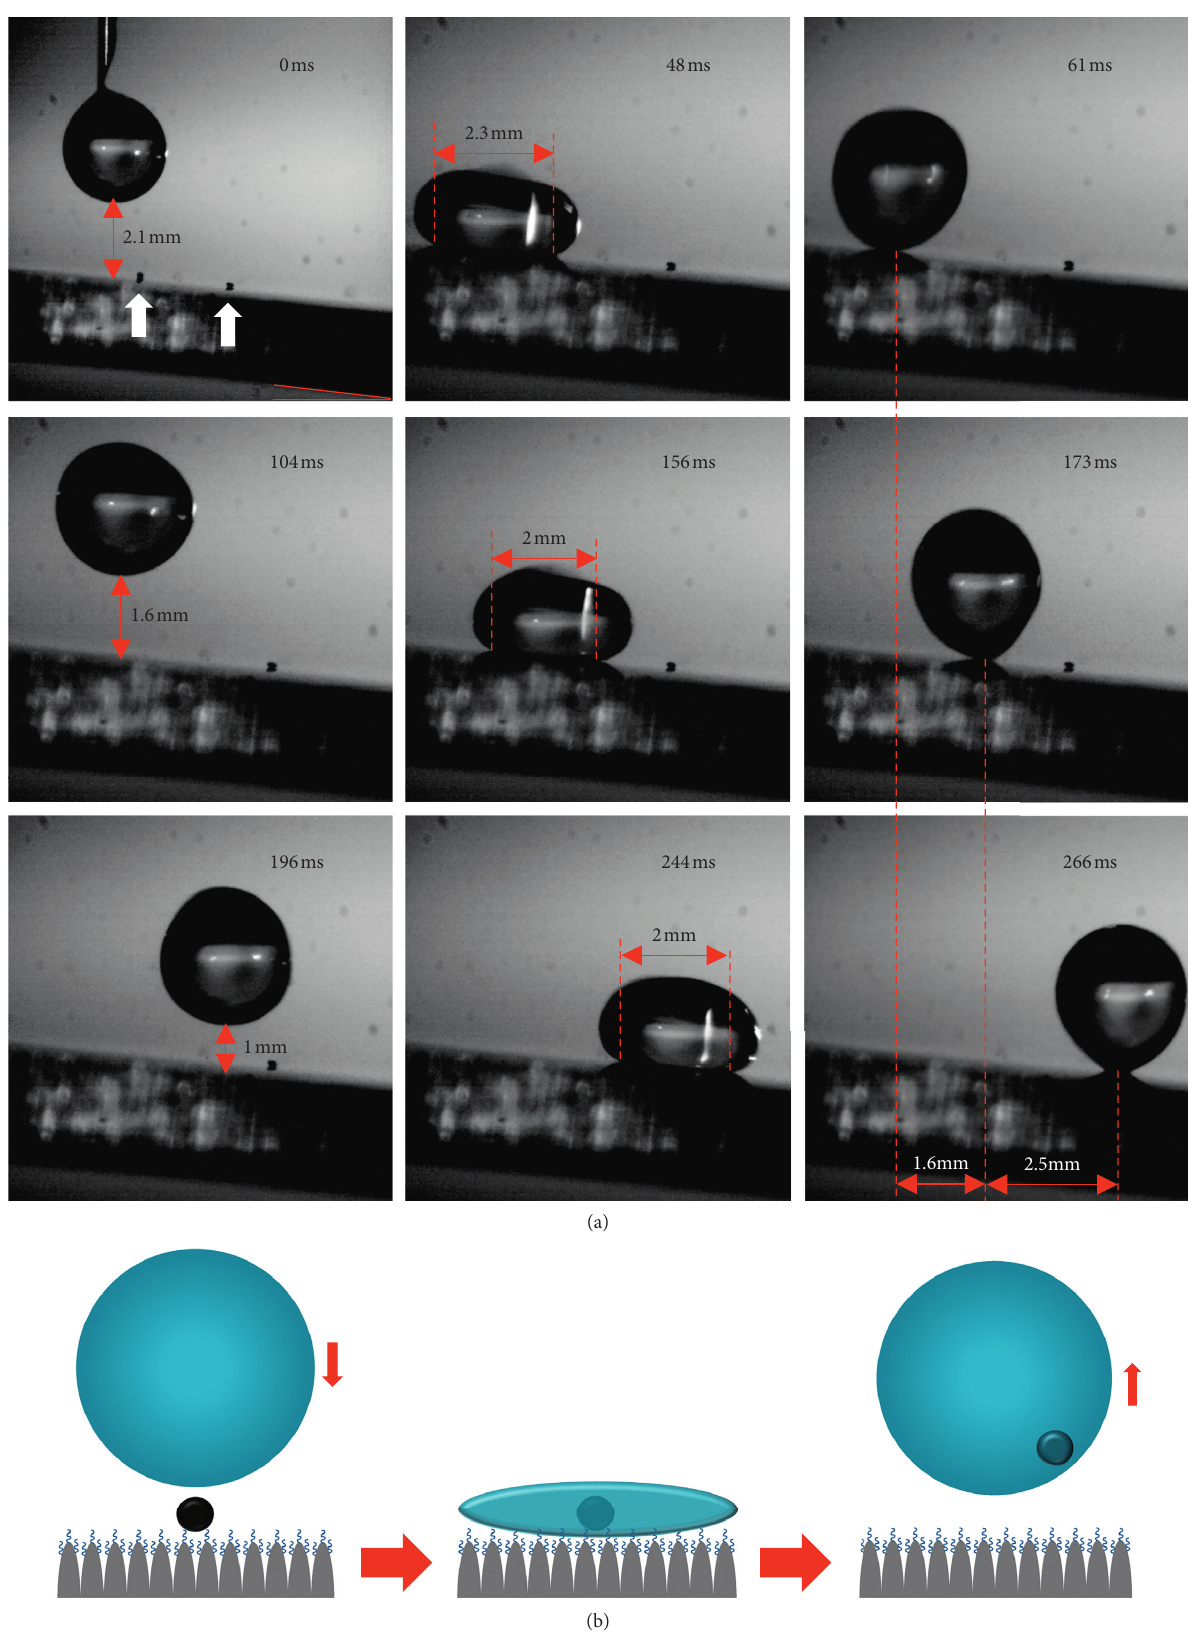
Figure 10: “Rebounding” cleaning mode: (a) high speed camera photos and (b) schematic of the particle removing